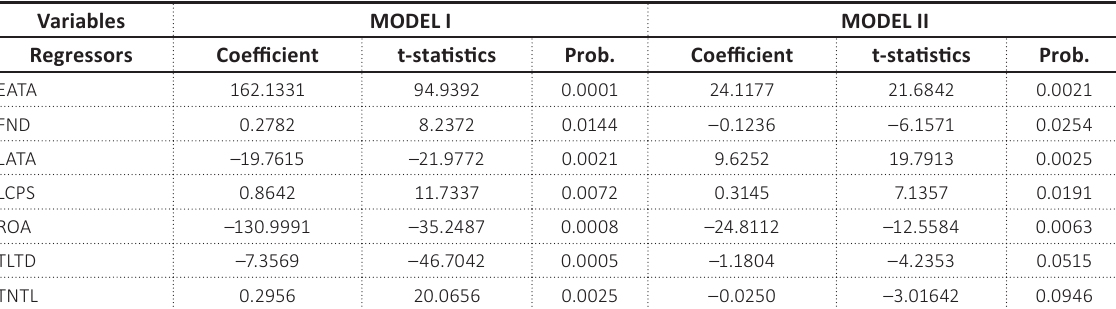
Source: Authors’ computation